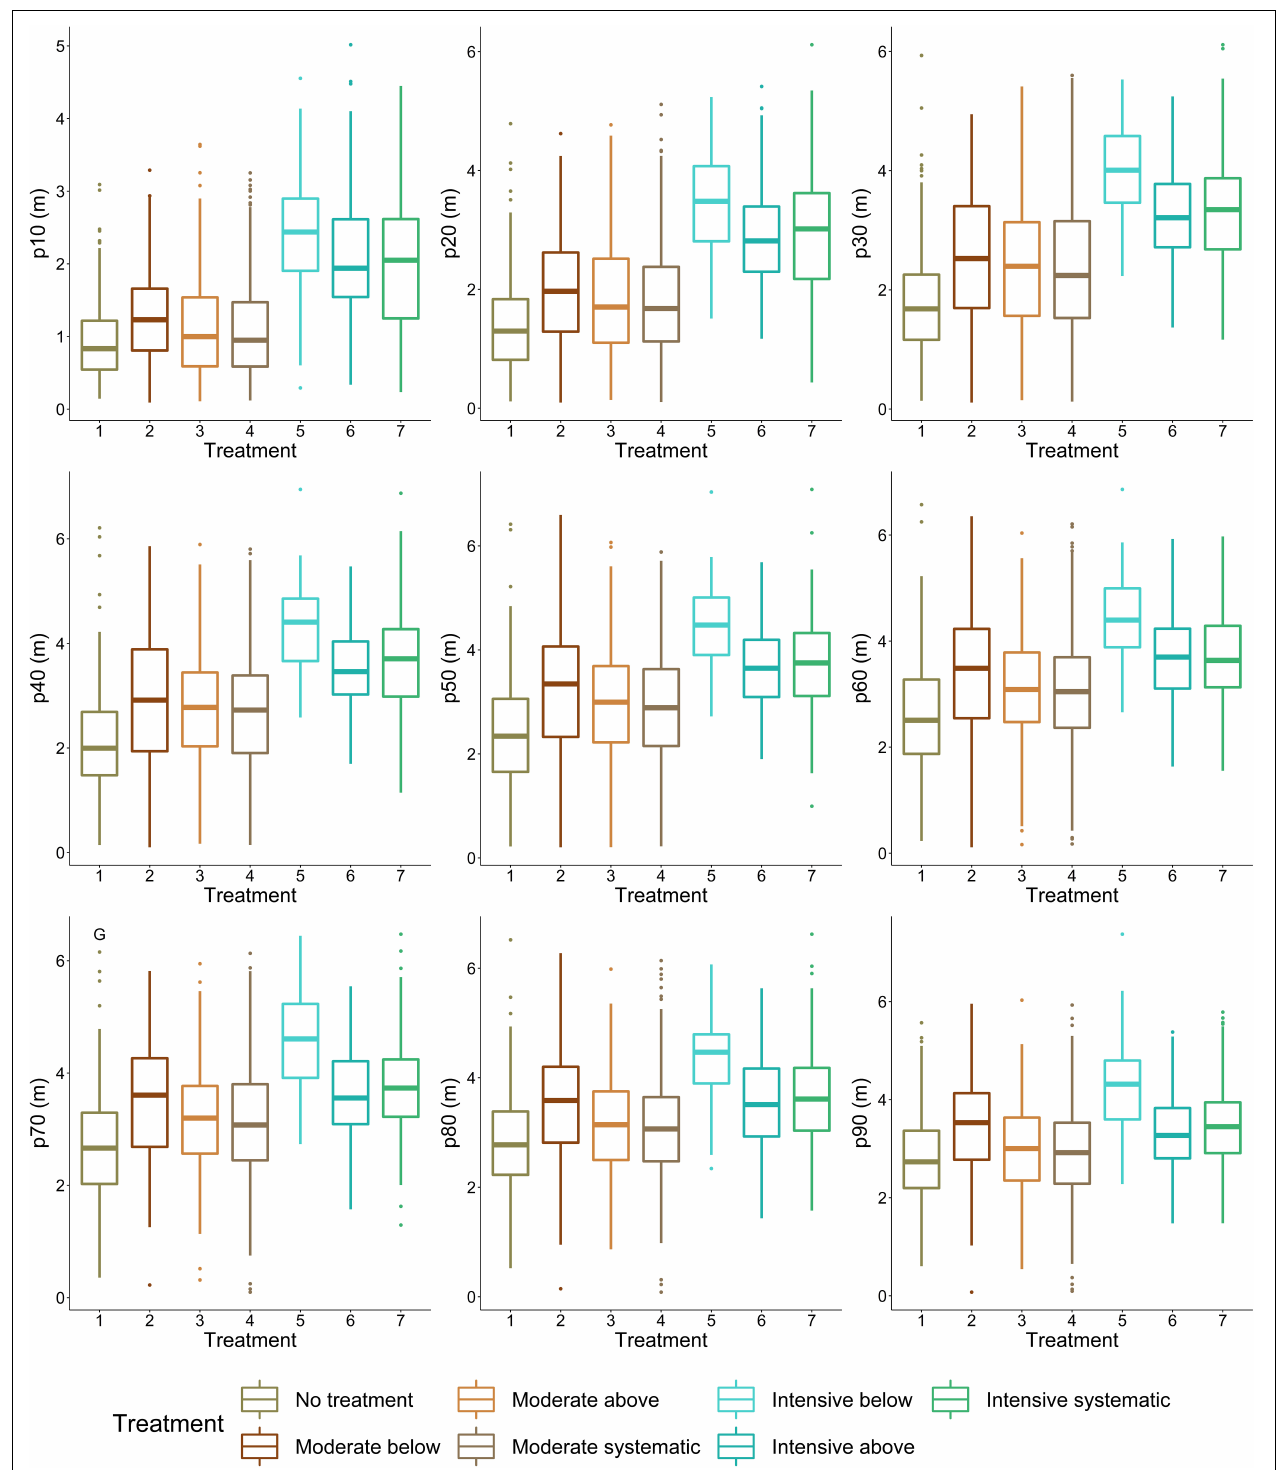
FIGURE 5 | Variation in crown diameter at height percentiles between thinning treatments. P10 indicates the lowest height percentile (i.e., the most bottom part of a crown), whereas p100 is the highest height percentile (i.e., the highest part of a crown). 1, no treatment (i.e., control); 2, moderate thinning from below; 3, moderate thinning from above; 4, moderate systematic thinning from above; 5, intensive thinning from below; 6, Intensive thinning from above; and 7, intensive systematic thinning from above.